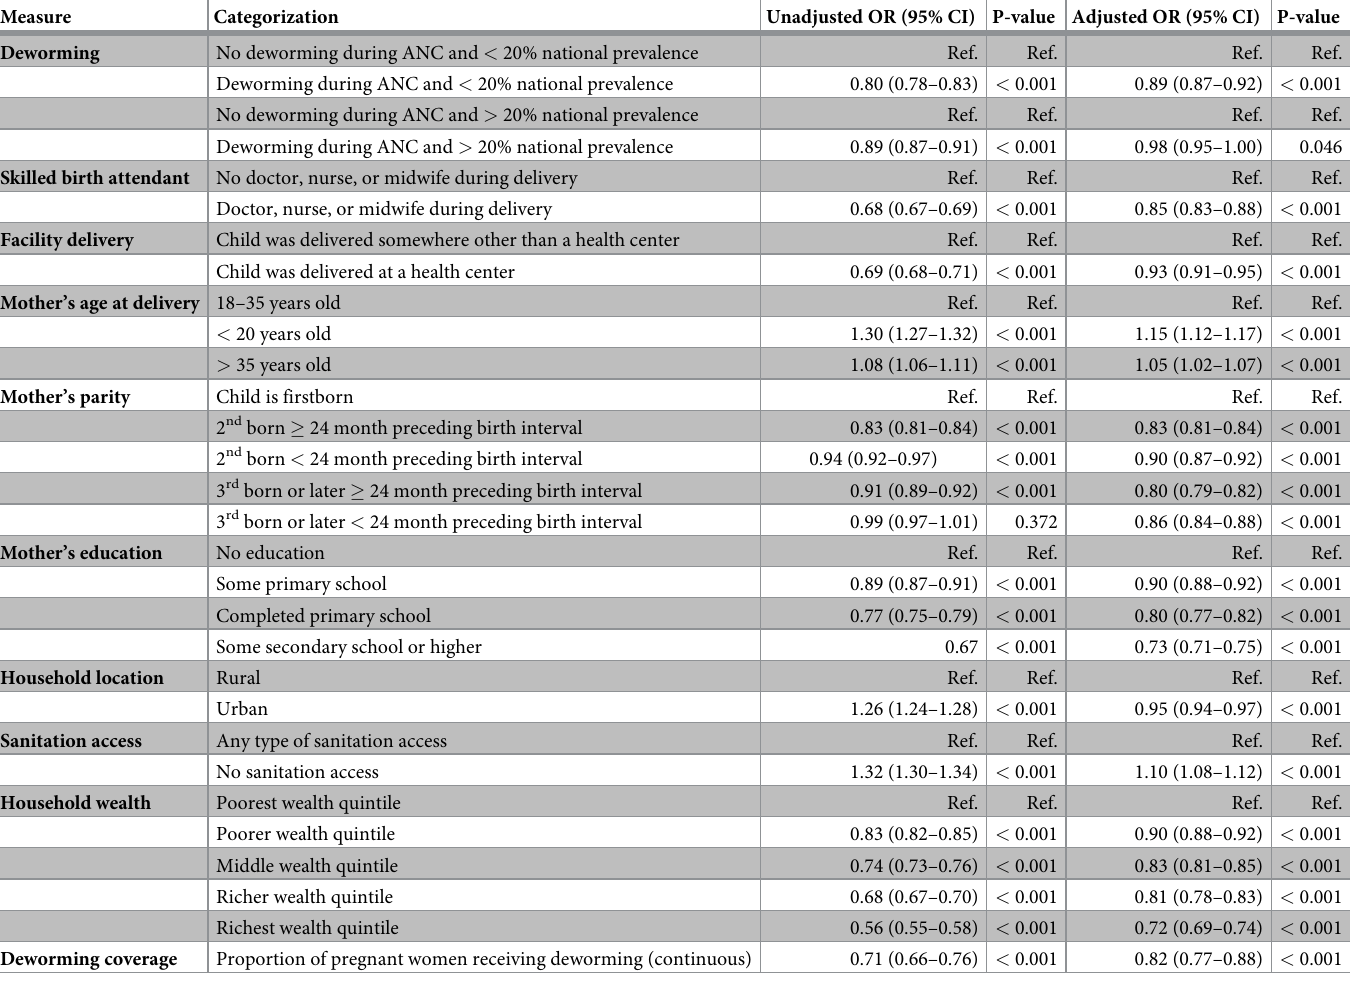
Table 3. Results from logistic regression analysis of deworming during ANC and low